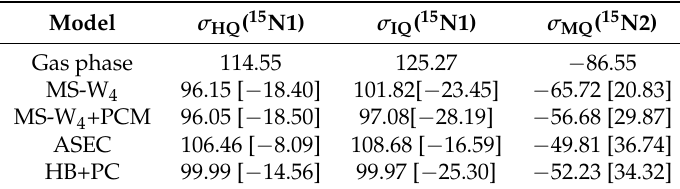
Table 1. B3LYP/6-311++G(2d,2p) results for 15 N shielding constants (in ppm) of HQ, IQ and MQ monomers. Chemical shifts relative to the gas phase are represented in